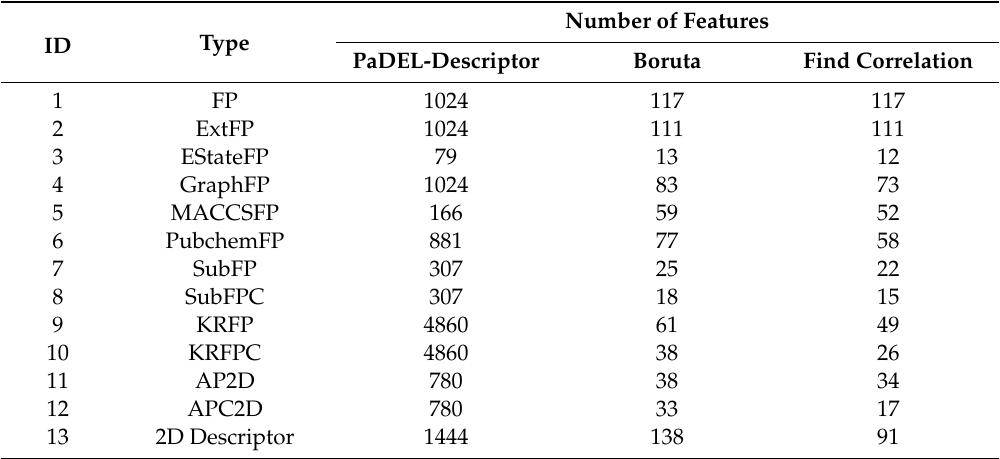
Table 1. Feature selection results of 13 types of molecular fingerprints /